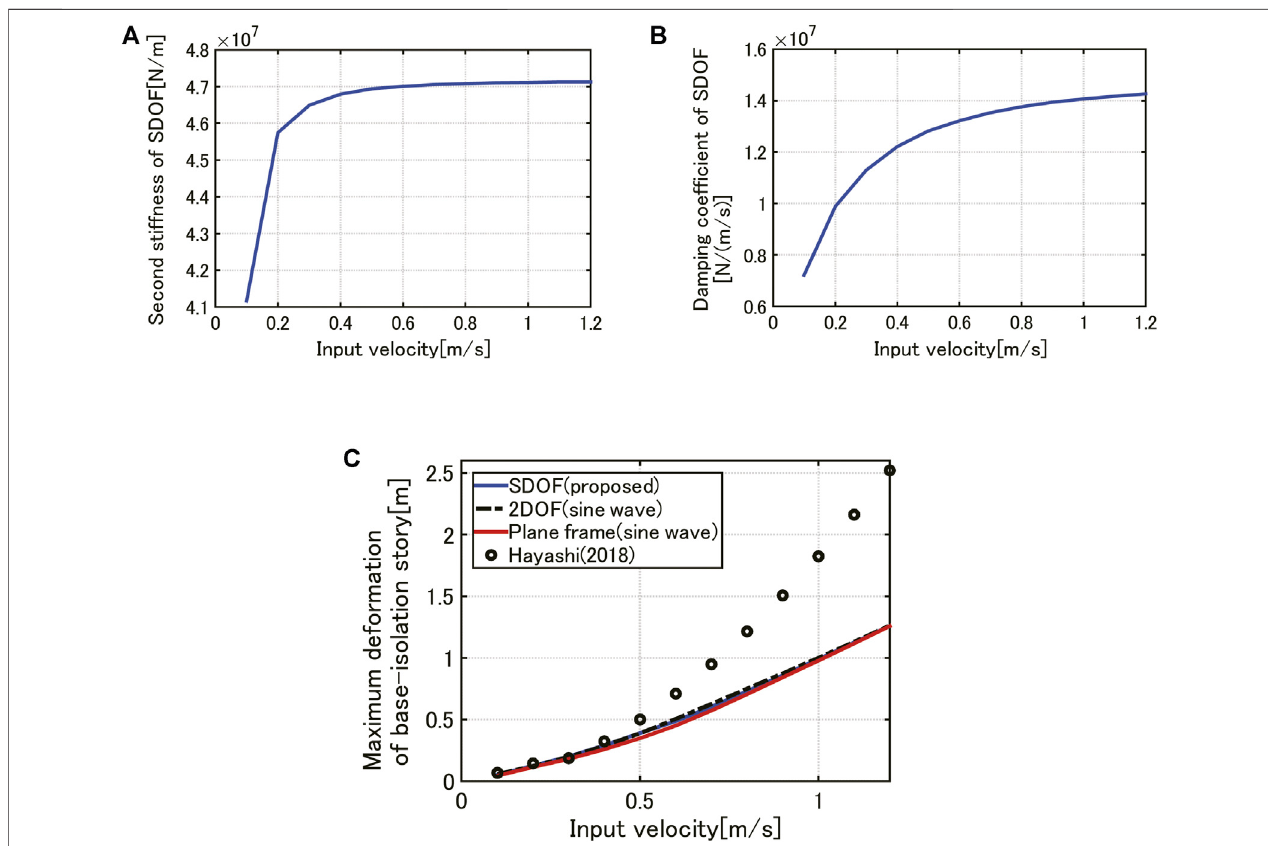
FIGURE6| ParametersofreducedSDOFmodelwithrespecttoinputvelocitylevelandaccuracycheckofproposedsimpleresponseevaluationmethodforSDOF model withrespect toinputvelocitylevel, (A) Second-branchstiffnessofSDOF model, (B) Damping coef fi cient, (C) Maximumdeformationcomparison ofbase-isolation story among proposed one, 2DOF model under one-cycle sine wave, plane frame under one-cycle sine wave and previous work by Hayashi (2018).